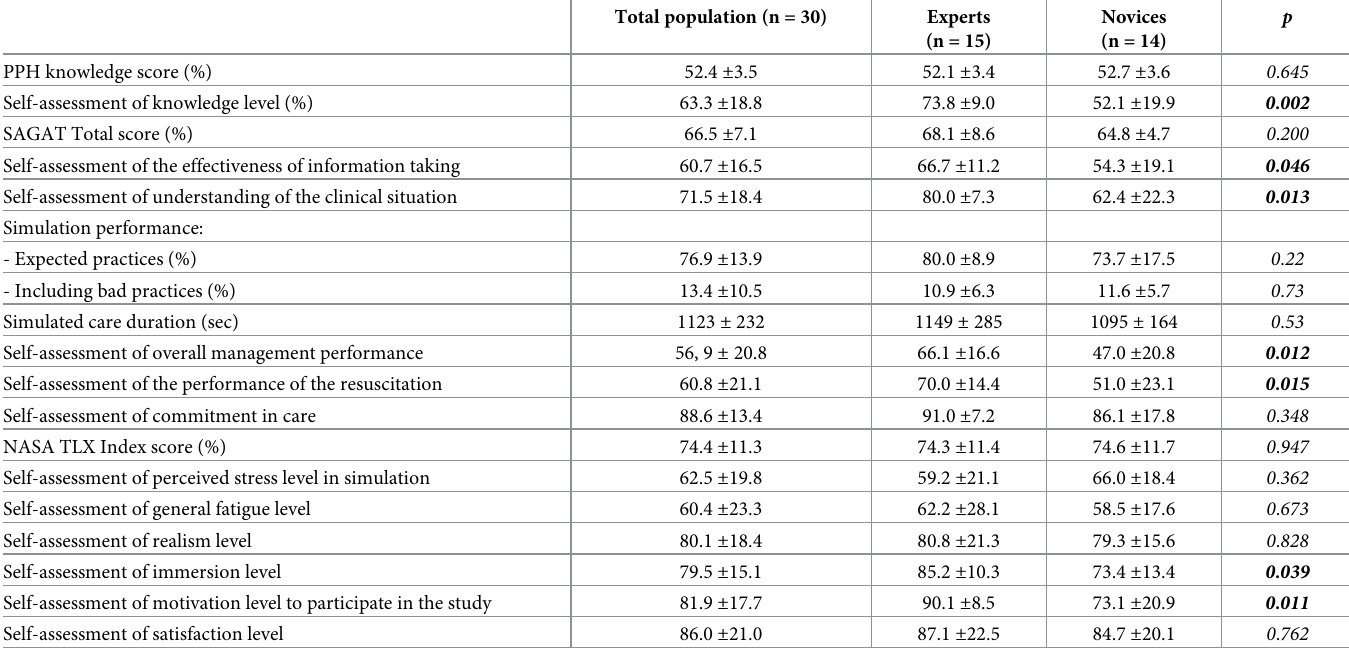
Table 2. PPH knowledge, PPH simulation performance and anesthetist post-test self-assessment.